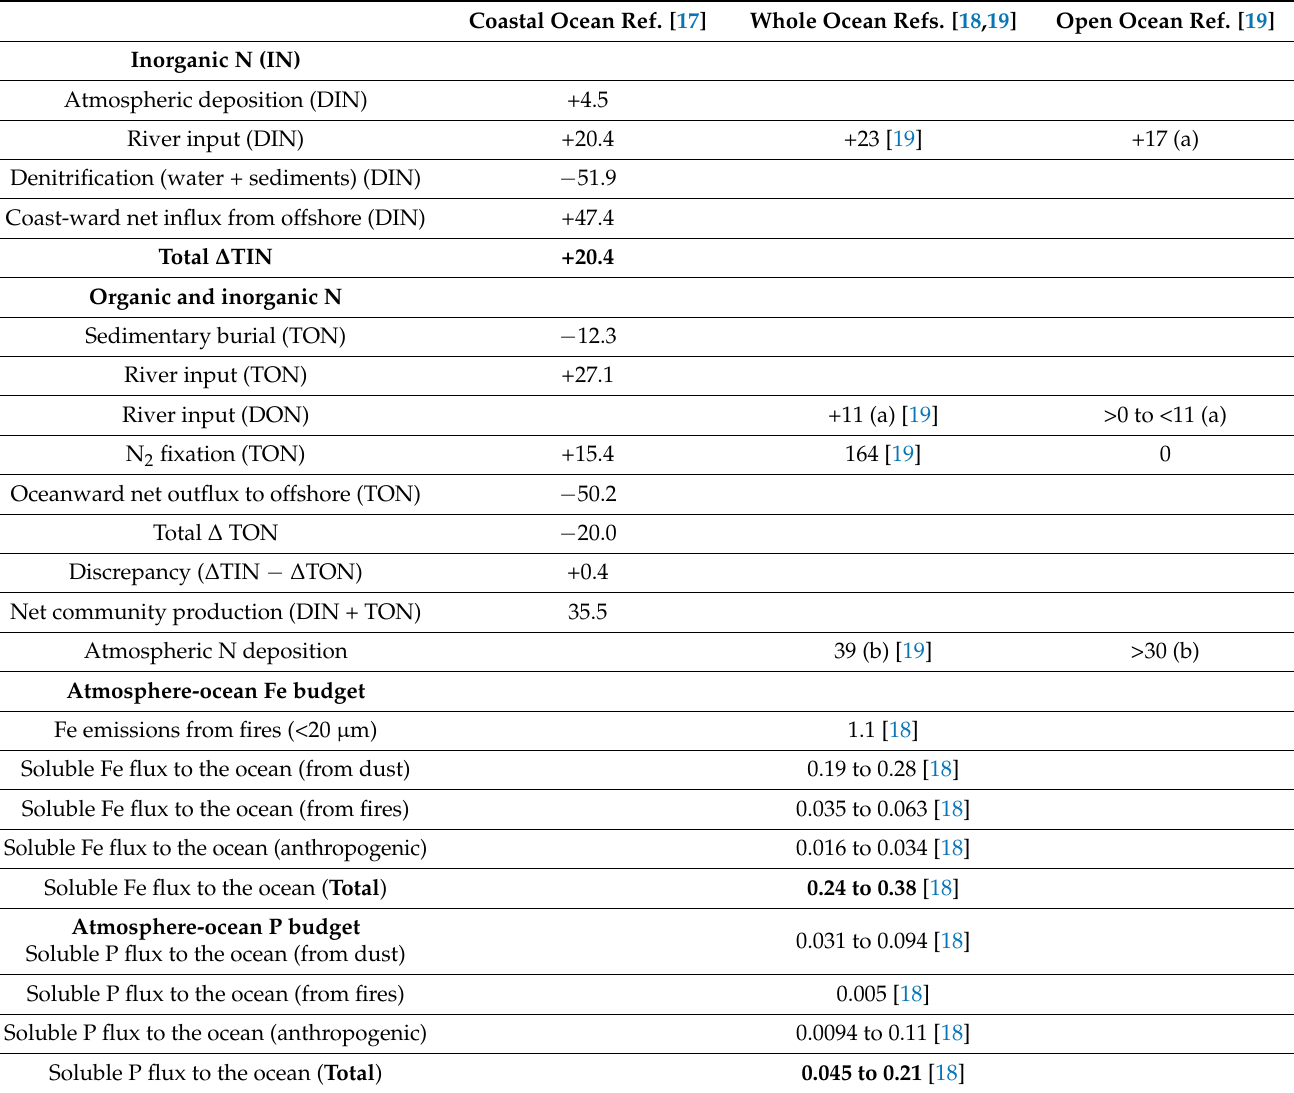
Table 1. Global coastal ocean nitrogen, N, and iron, Fe, budget terms (Tg y − 1 ) (estimated annual